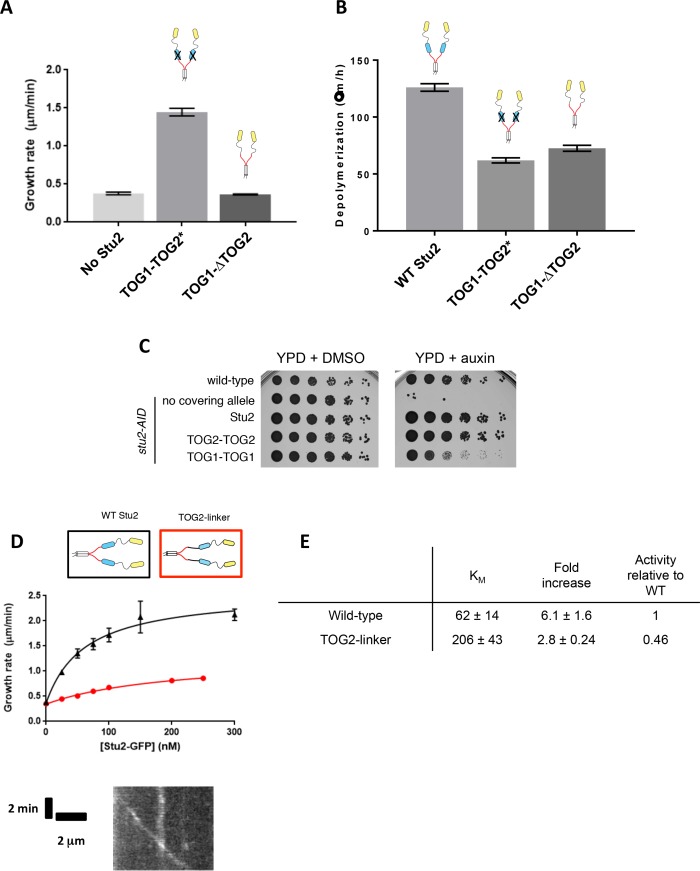
Effects of inactivating, deleting, or replacing the basic-proximal TOG domain.(A) Deleting the TOG2 domain (Stu2(TOG1-ΔTOG2)) abolishes polymerase activity. Polymerase activity is retained when the TOG2 domain is inactivated by mutagenesis. Samples were analyzed with 200 nM Stu2 in the presence of 0.8 μM tubulin in dynamic assays. N = 25 end measurements for all; error bars are SEM. (B) Deleting the TOG2 domain (Stu2(TOG1-ΔTOG2)) does not compromise the tubulin binding activity of TOG1 as judged in a ‘depolymerase’ assay wherein TOG domains cause the depolymerization of stable microtubules. Samples were analyzed with 200 nM Stu2 in the presence unlabeled GTPγS stabilized MTs. N = 20 measurements for all. Error bars show SEM. (C) Wild-type (SBY3), stu2-AID (SBY13772) and stu2-AID cells expressing various STU2-3V5 alleles from an ectopic locus (wildtype, SBY13901; TOG1∆, SBY13904; TOG2-TOG2, SBY16931; TOG1-TOG1, SBY17595) were serially diluted (5-fold) and spotted on plates containing either DMSO or 500 μM auxin. A Stu2 variant in which TOG2 is replaced with a second copy of TOG1 (Stu2(TOG1-TOG1)) partially rescues the loss of endogenous Stu2 in a genetic rescue assay, but to a lesser degree than that of a Stu2(TOG2-TOG2) variant. (D) Inserting a flexible, 16 amino acid spacing linker between the end of TOG2 and the basic domain weakens the polymerase activity of Stu2 bud does not abolish end localization, shown in the representative kymograph (bottom). Black: N = 45 measured from three different chambers; red: N = 20 measurements. Error bars show SEM. Smooth curves indicate a hyperbolic fit to the data. (E) Summary statistics of hyperbolic fits to the activity measurements shown in D.10.7554/eLife.34574.009Figure 2—figure supplement 1—source data 1.Numerical data associated with Figure 2—figure supplement 1.